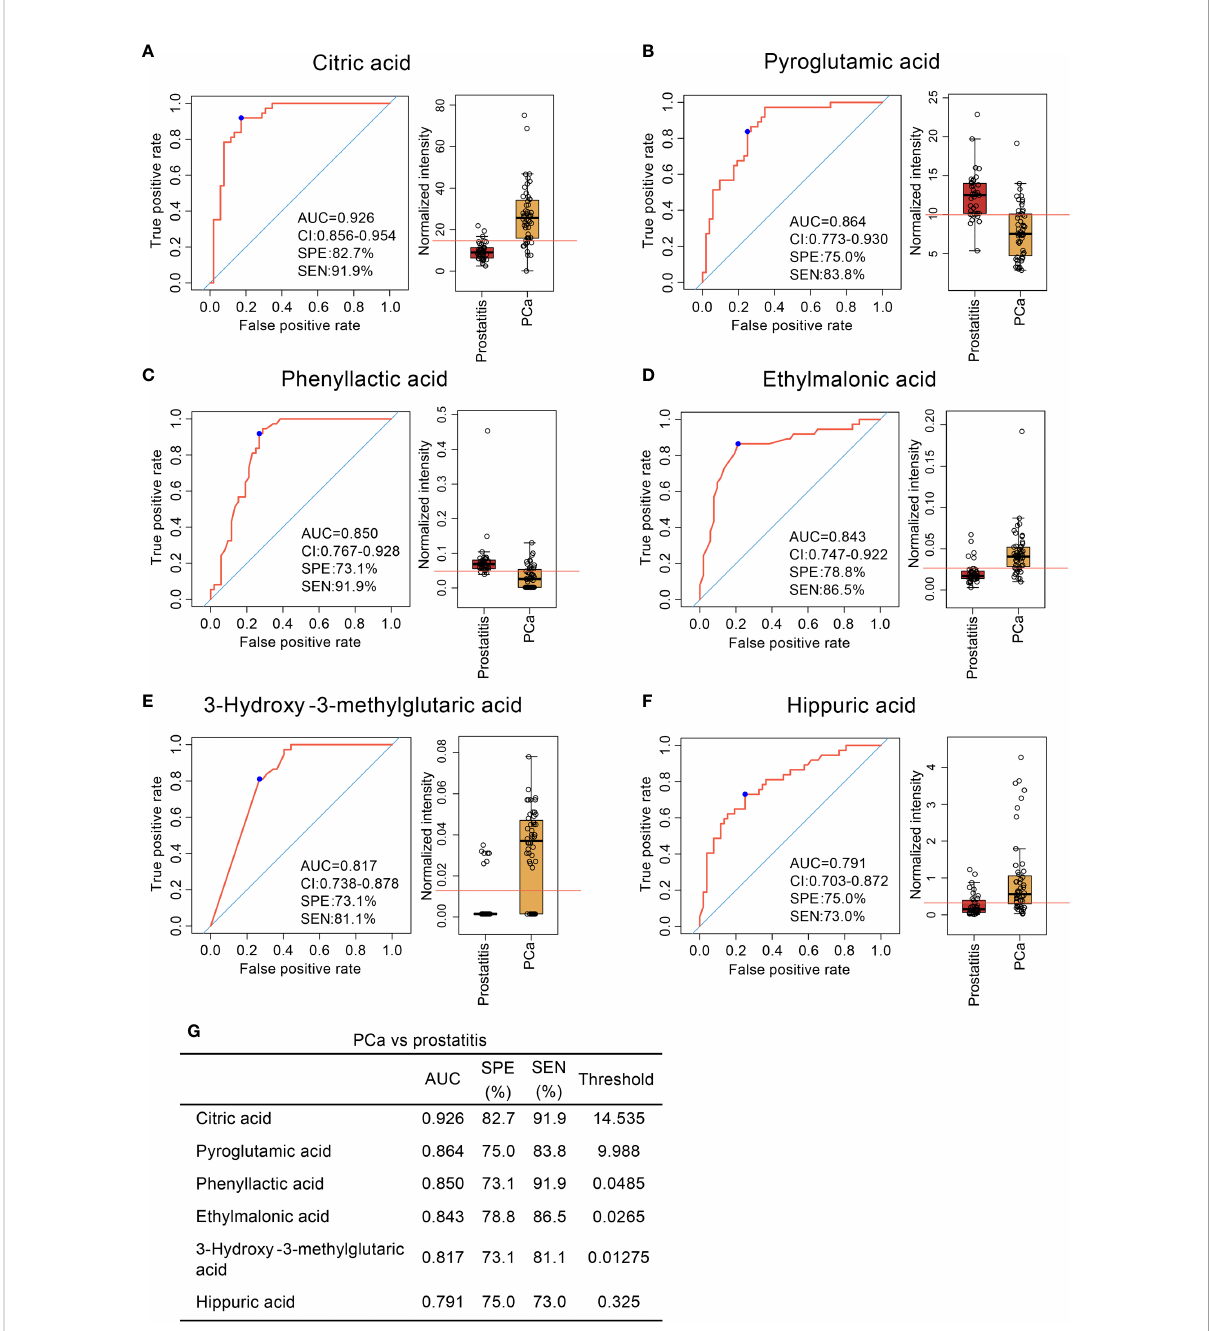
FIGURE 3 Comparison of organic acid metabolites in the serum of patients with prostate cancer and patients with prostatitis and ROC curve analysis. (A – F) Comparison of citric acid, pyroglutamic acid, phenyllactic acid, ethylmalonic acid, 3-hydroxy-3-methylglutaric acid, and hippuric acid content in the serum of patients with prostate cancer and patients with prostatitis and ROC curve analysis. (G) Diagnostic models of serum organic acid metabolites used to distinguish prostate cancer from